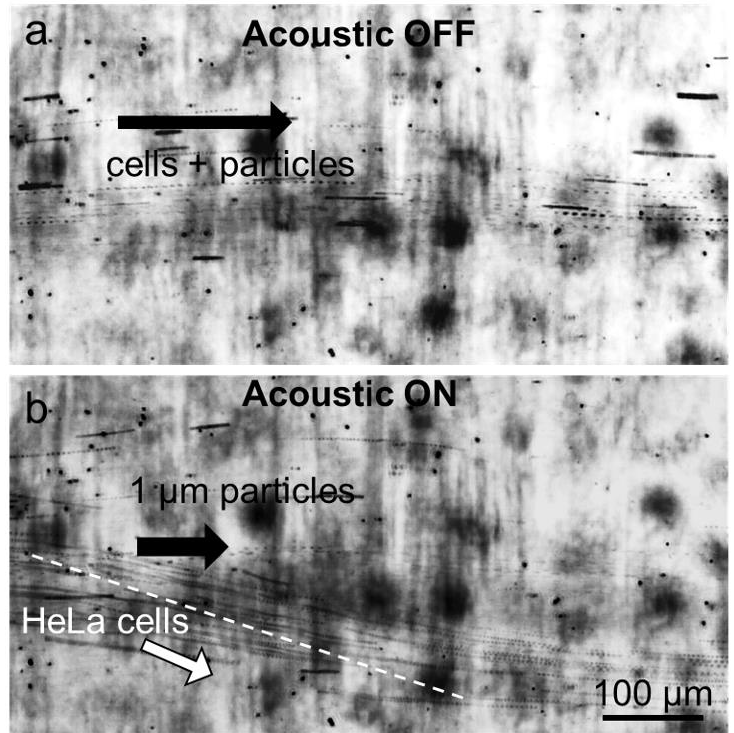
Figure 5 . Separation of HeLa cells and polystyrene particles is shown by stacked images. ( a ) When the acoustic field is turned off, the mixture of the particles and cells flow together. ( b ) In the standing acoustic wave field, HeLa cells mostly follow the pressure nodes and separated from the smaller polystyrene particles.